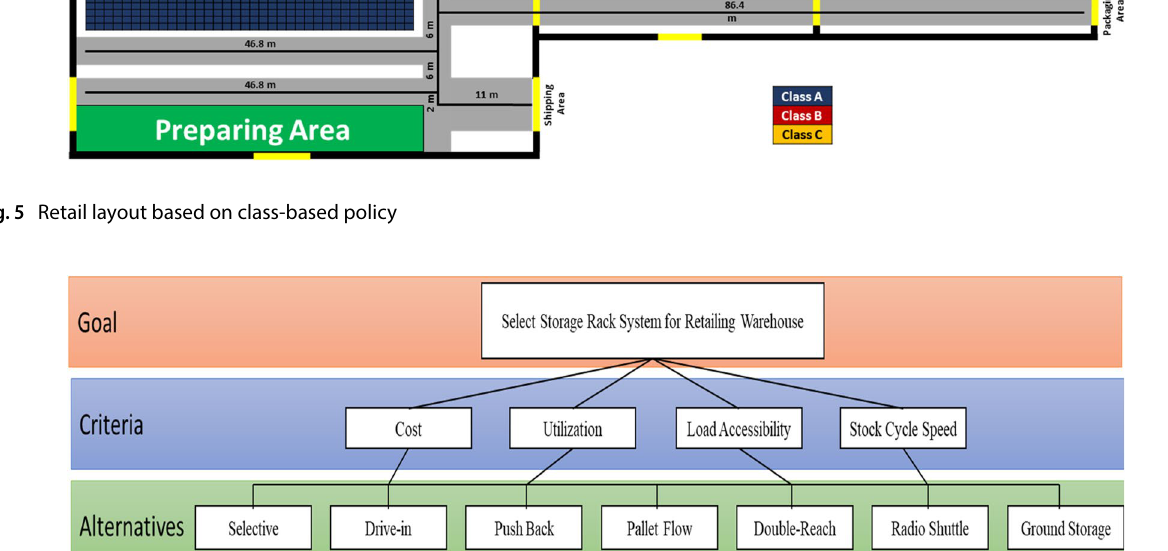
Fig. 6 AHP hierarchy model for warehouse